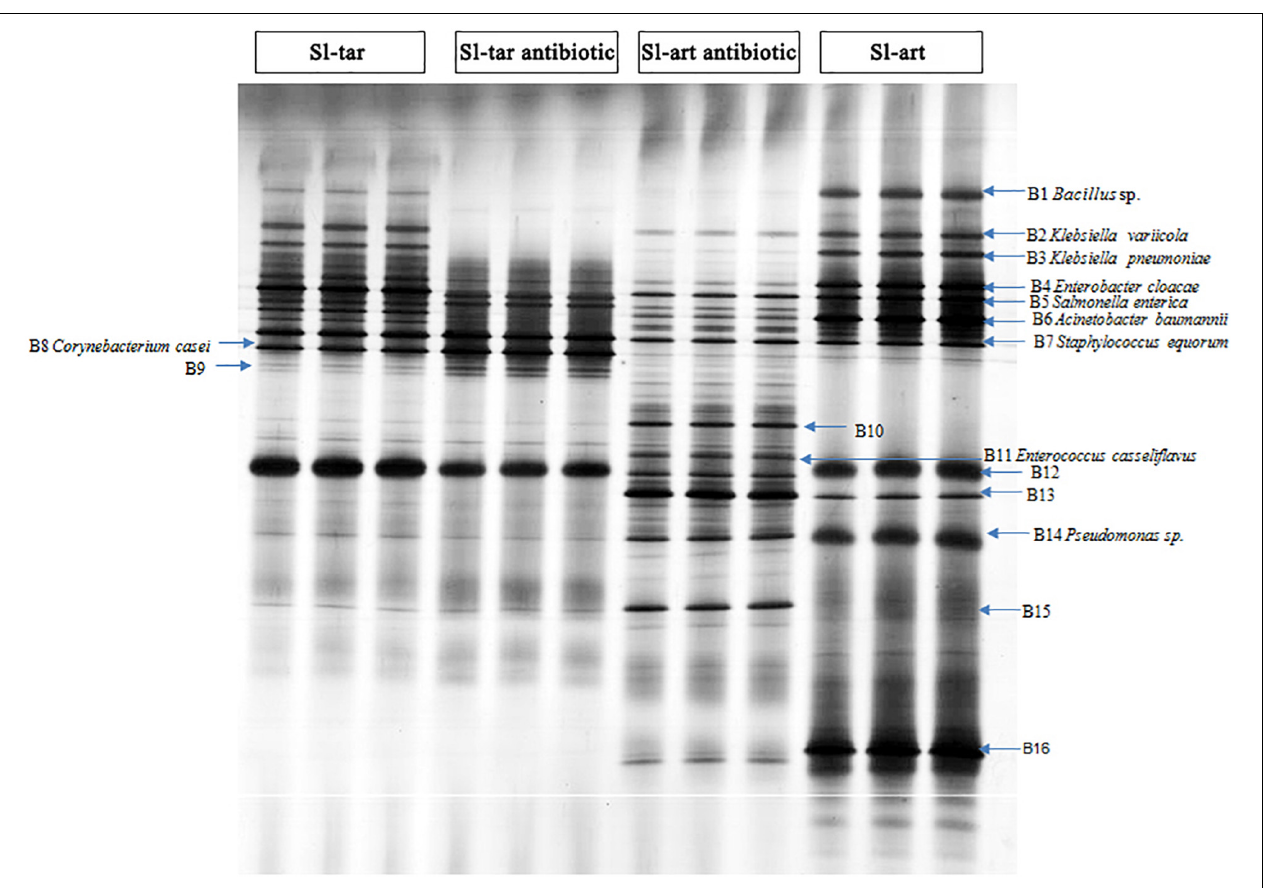
FIGURE 3 | DGGE analysis of S. litura gut microbes. Sl-tar, S. litura reared on taro leaves; Sl-art, S. litura reared on artificial diet; Sl-tar antibiotic, S. litura reared on taro leaves containing antibiotics; Sl-art antibiotic, S. litura reared on artificial diet containing